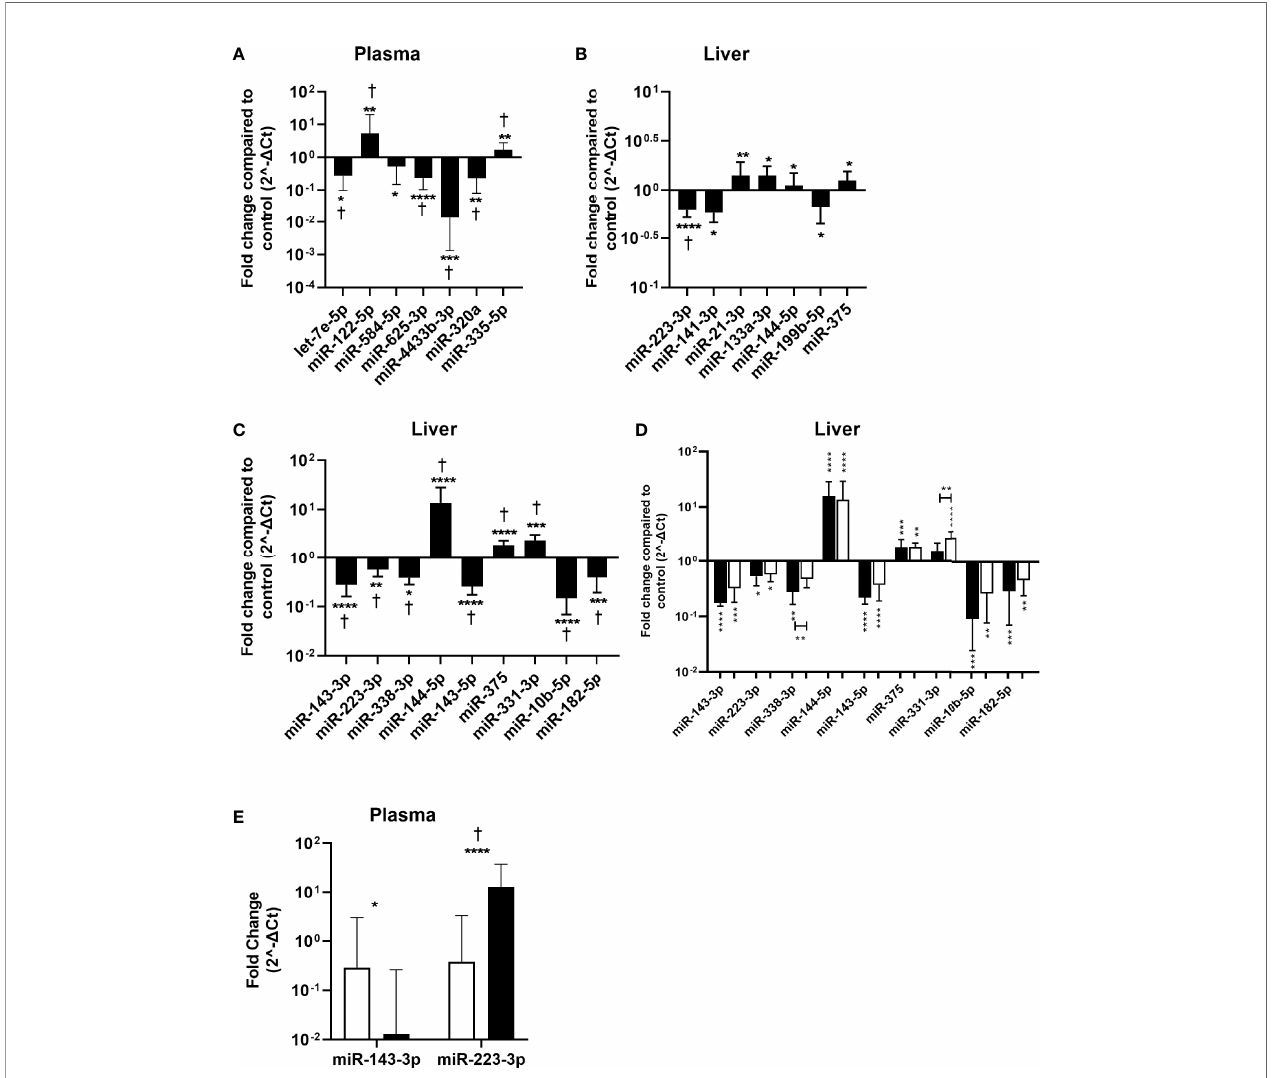
FIGURE 3 | Validation of identi fi ed miRNAs in plasma and liver tissue samples. miRNA expression in plasma and liver tissue was determined by RT qPCR and was compared between the CHB patients and controls. The fold change in normalized miRNA expression levels in plasma samples (n=141) of the fi rst conformation cohort (A) , liver tissue samples of the fi rst (n=87) (B) or second (n=32) (C) conformation cohort as compared to controls (plasma n=10, liver n=13) are shown. (D) The fold change of normalized miRNA expression levels in liver tissue from HBeAg positive (black bars) and HBeAg negative (open bars) patients from the second cohort as compared to controls are shown. (E) Differential expression of con fi rmed CHB associated liver miRNAs in plasma. Open bars represent the control and black bars the CHB patients. Data is presented as median and interquartile range. Differences between the groups were determined by Mann Whitney U test and only signi fi cant differently expressed miRNAs are shown. * p<0.05; ** p<0.01; *** p<0.001; **** p<0.0001. For panel (A – C) † represents p<0.05 after correction for multiple